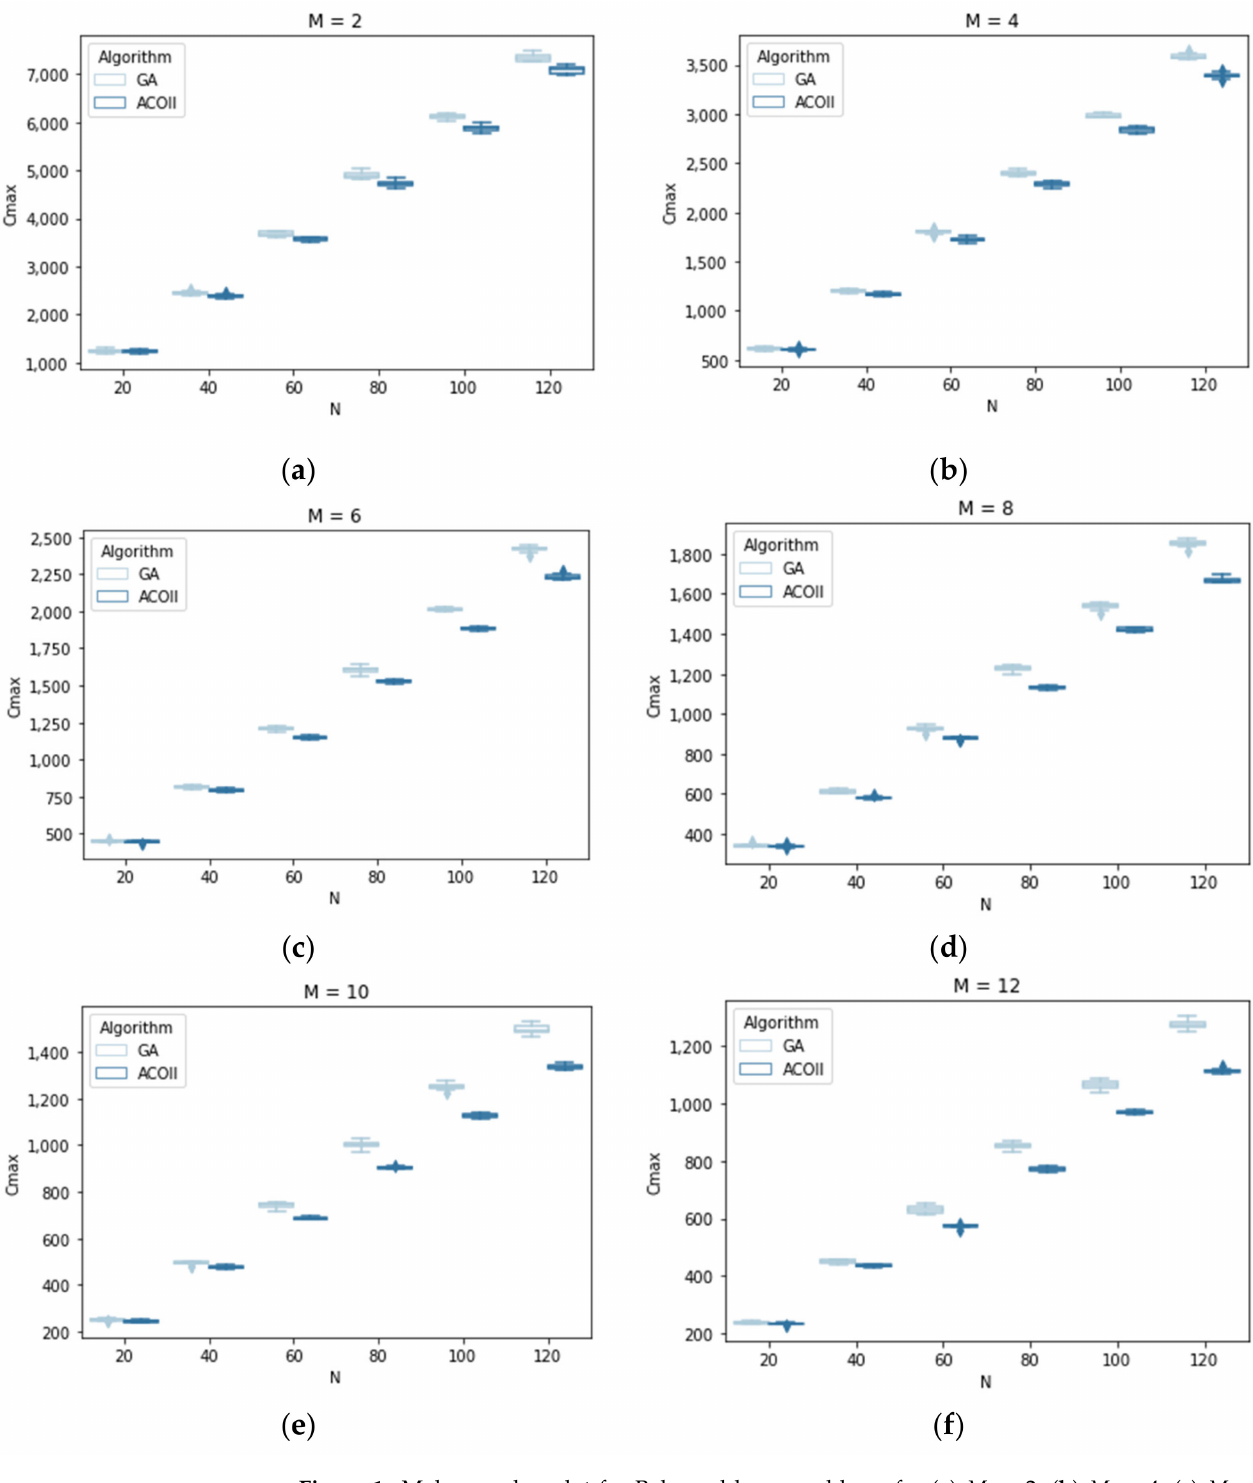
Figure 1. Makespan boxplot for Balanced large problems for ( a ) M = 2; ( b ) M = 4; ( c ) M = 6; ( d ) M = 8; ( e ) M = 10; ( f ) M =